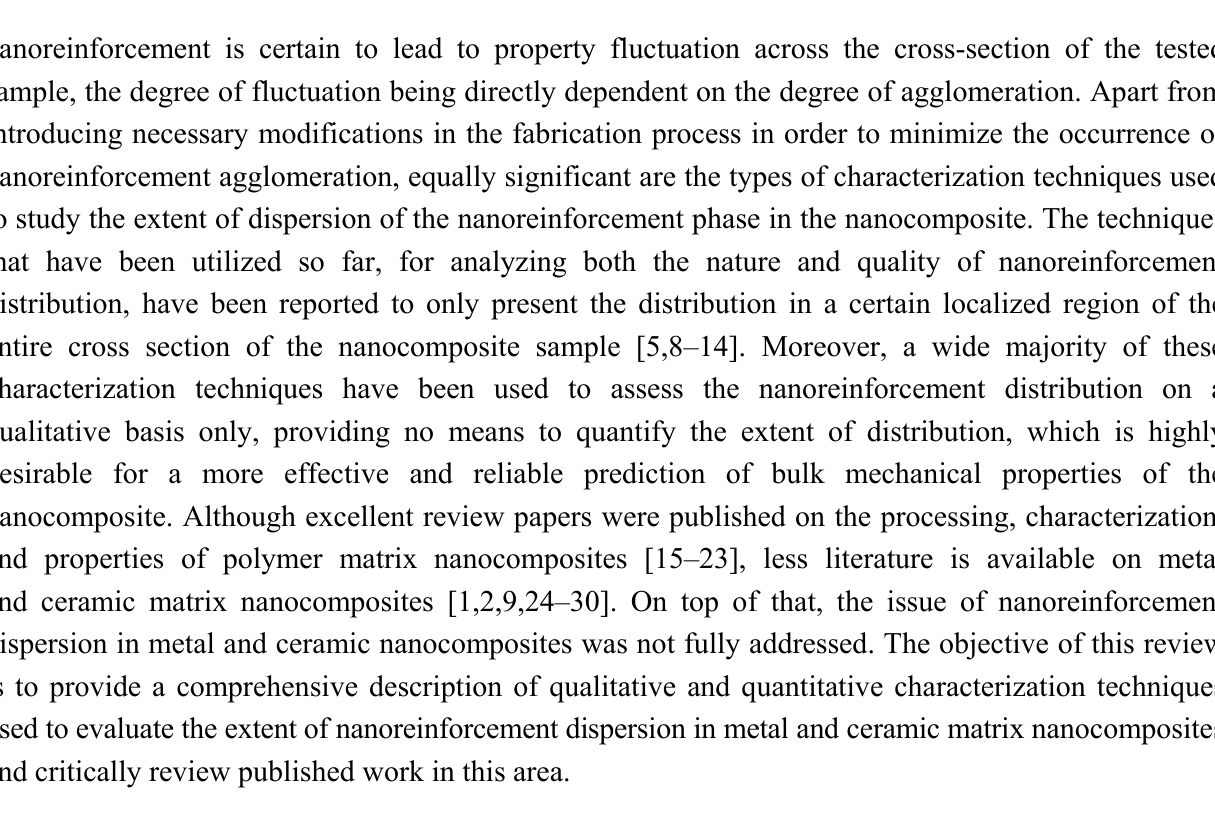
Figure 1. Possible distribution of the matrix and reinforcement phases in a nanocomposite. The reinforcement phase is distributed ( a ) along the grain boundaries of the matrix; ( b ) inside the grains of the matrix; ( c ) both inside the grains and along the grain boundaries; or ( d ) both the matrix and reinforcement grains are uniformly distributed